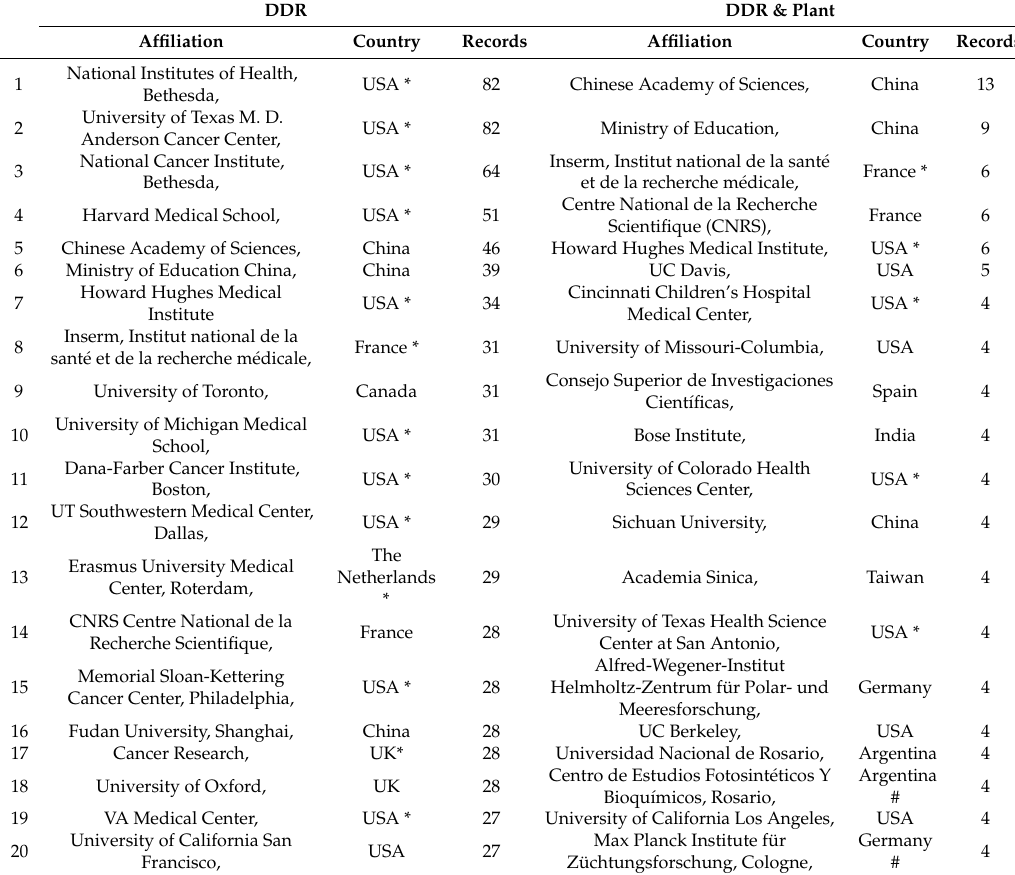
Table 3. Rankings of the 20 most productive institutions in the DDR research field and in DDR research in the plant